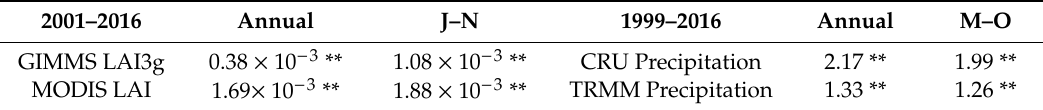
Table 3. Trend analysis of the LAI between 2001 and 2016 and precipitation of 1999–2016 from di ff erent